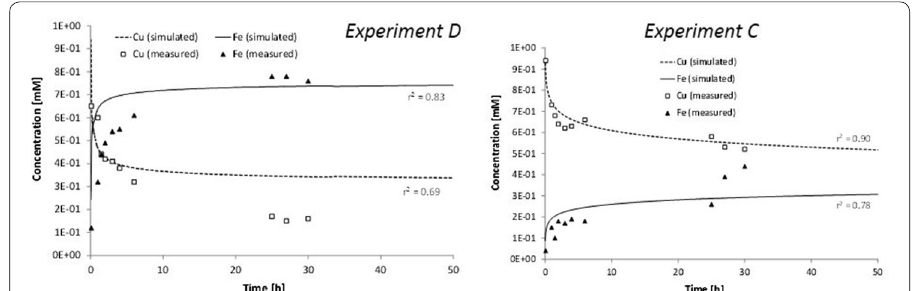
Fig. 7 Simulated data compared to experimental measurements of Cu and Fe concentration as result of the redox reaction. Left Experiment D (anoxic, 80 °C, salt-poor); Right experiment C (anoxic, 80 °C, salt-rich